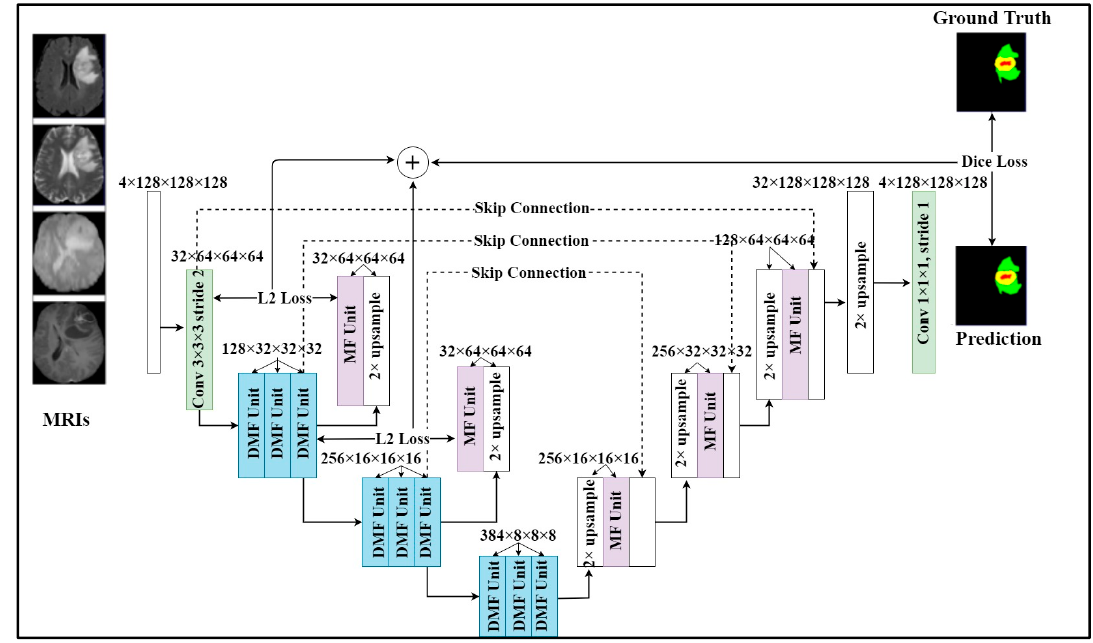
Figure 1. Our proposed multi-task learning network with two tasks. One task is brain tumor segmentation. We add the additional feature reconstruction task to our model as an auxiliary task to help retain important features when downsampling. The model takes a sequence of MRI modalities as input and generates the brain tumor mask.